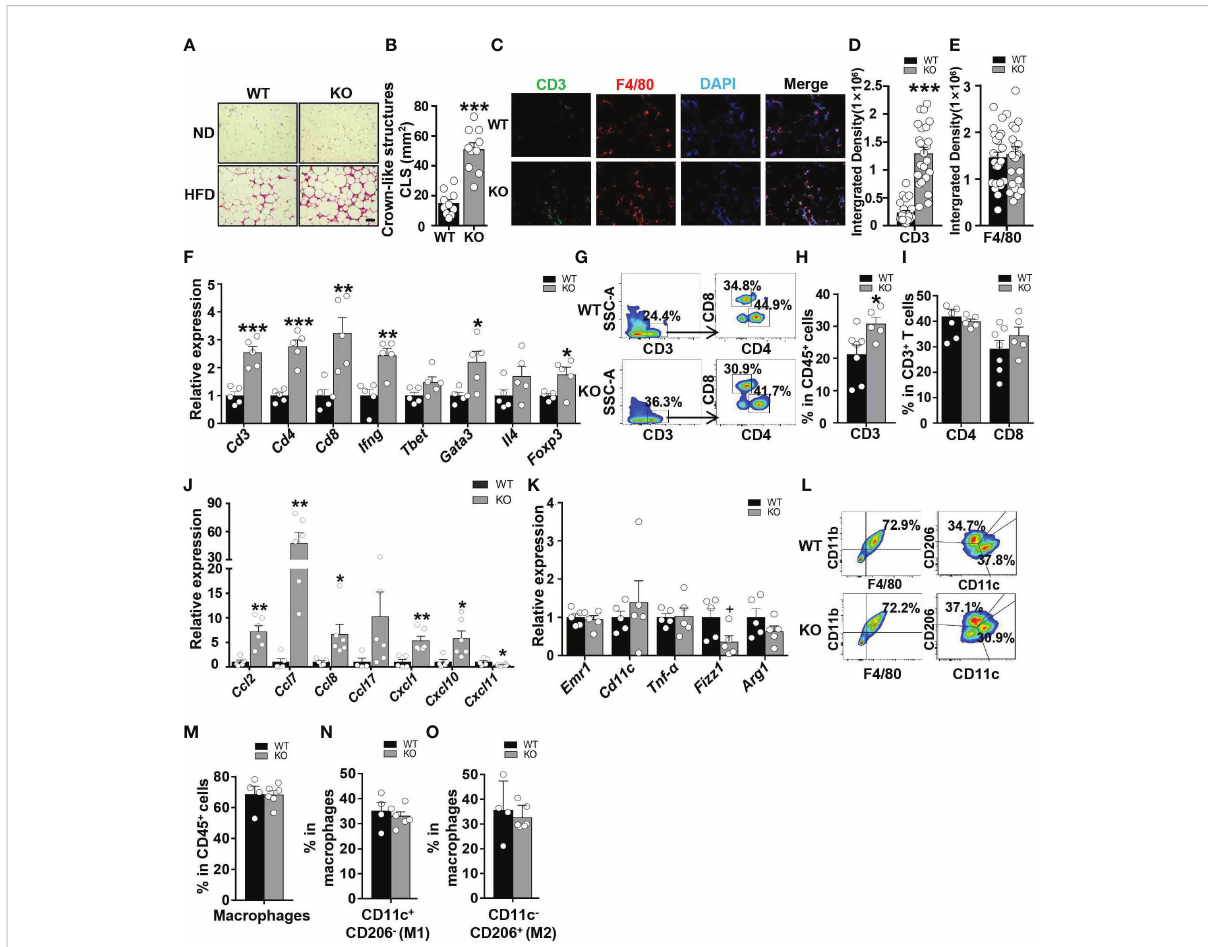
FIGURE 4 CCL5 de fi ciency exacerbates HFD-induced adipose in fl ammation. (A) Representative H&E staining of eWAT from WT and CCL5 KO mice after ND-fed and 16-week HFD-fed. Scale bar: 100 m m. (B) Quanti fi cation of CLSs in WT and CCL5 KO mice after 16 weeks HFD. (n = 10 high power fi elds from 4 animals in each group). (C) Representative immuno fl uorescent staining of the eWAT from mice fed a HFD using anti-CD3 (green) and anti-F4/80 (red) antibodies. Scale bar: 100 m m. (D, E) Quanti fi cation of images for CD3 (D) and F4/80 (E) integrated density in eWAT from WT and CCL5 KO mice after 16 weeks HFD. (n = 25 high power fi elds from 4 animals in each group). (F) mRNA expression of T cell marker genes in eWAT of WT and CCL5 KO mice after 16 weeks HFD. (n = 5 mice per group). (G) Representative fl ow cytometry plots of CD3 + T cells, CD4 + T cells, and CD8 + T cells in eWAT of WT and CCL5 KO mice after 16 weeks HFD. (H) Quanti fi cation of CD3 + T cells in CD45 + cells in eWAT of WT and CCL5 KO mice after 16 weeks HFD. (n = 5-7 mice per group). (I) Quanti fi cation of CD4 + T cells, CD8 + T cells in CD3 + cells in eWAT of WT and CCL5 KO mice after 16 weeks HFD. (n = 5-7 mice per group). (J) mRNA expression of chemokine genes in eWAT of WT and CCL5 KO mice fed a HFD. (n=4-6 mice per group). (K) mRNA expression of macrophage marker genes in eWAT of WT and CCL5 KO mice after 16 weeks HFD. (n = 5 mice per group). (L) Representative fl ow cytometry plots of macrophages in eWAT of WT and CCL5 KO mice after 16 weeks HFD. CD11c + CD206 - (M1-type) and CD11c - CD206 + (M2-type). (M) Quanti fi cation of macrophages in eWAT of WT and CCL5 KO mice after 16 weeks HFD. (n=4-6 mice per group). (N, O) Quanti fi cation of M1-type (M) and M2-type macrophages (N) in total macrophages of eWAT from WT and CCL5 KO mice after 16 weeks HFD. (n=4-6 mice per group). Data are mean ± s.e.m. + p <0.1, * p <0.05, ** p <0.01, *** p <0.001 by unpaired Student ’ s